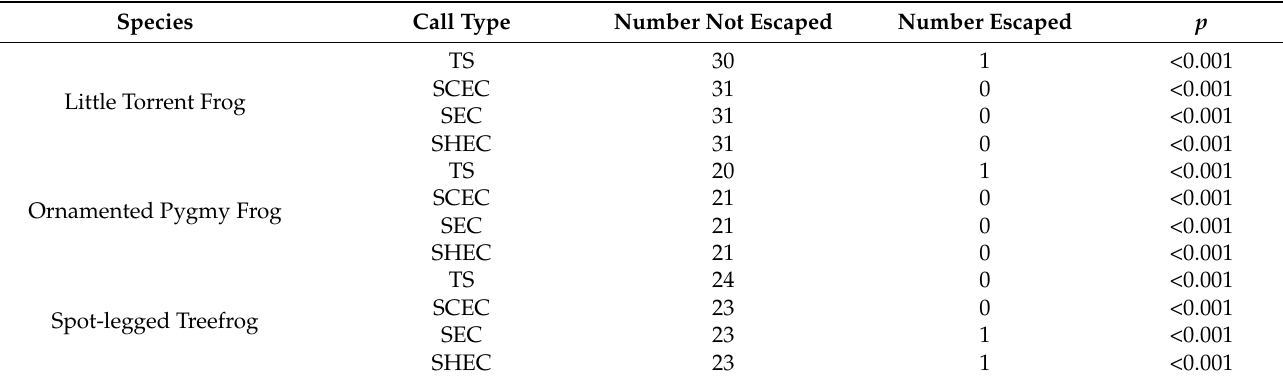
Table 2. Movement responses of Little Torrent Frogs, Ornamented Pygmy Frogs and Spot-legged Treefrogs to different